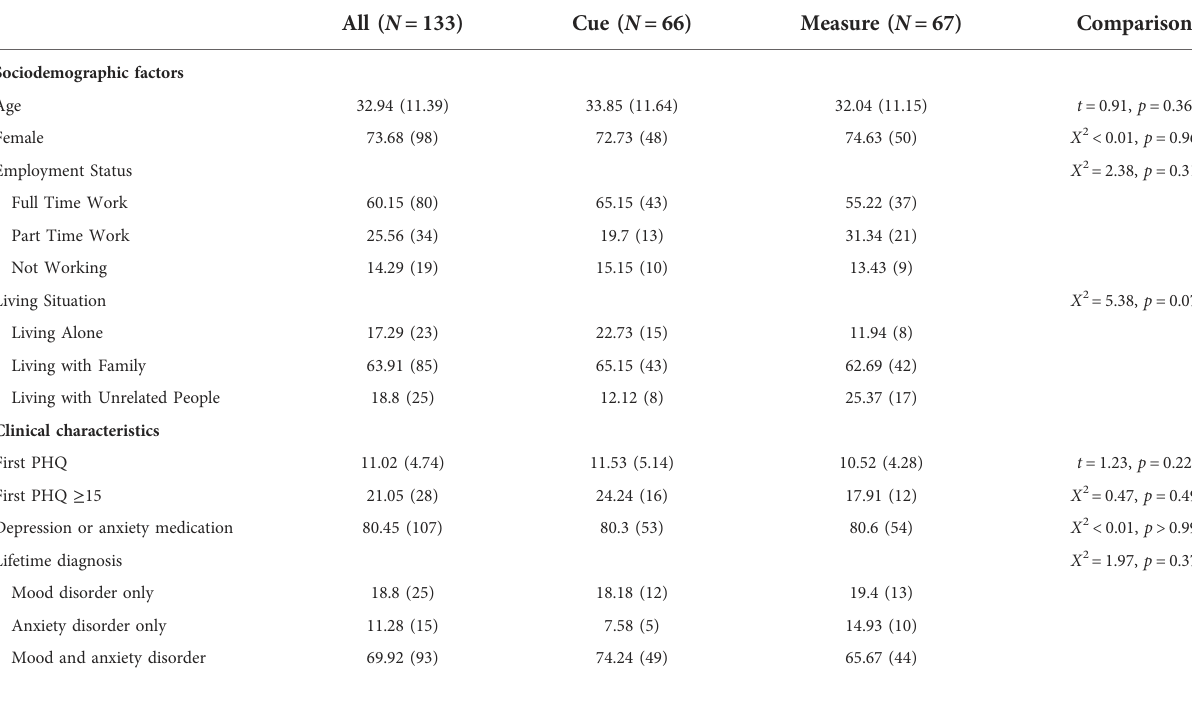
TABLE 1 Demographic and clinical characteristics for the full study sample – Cells show mean (SD) for continuous and % ( N ) for categorical measures.